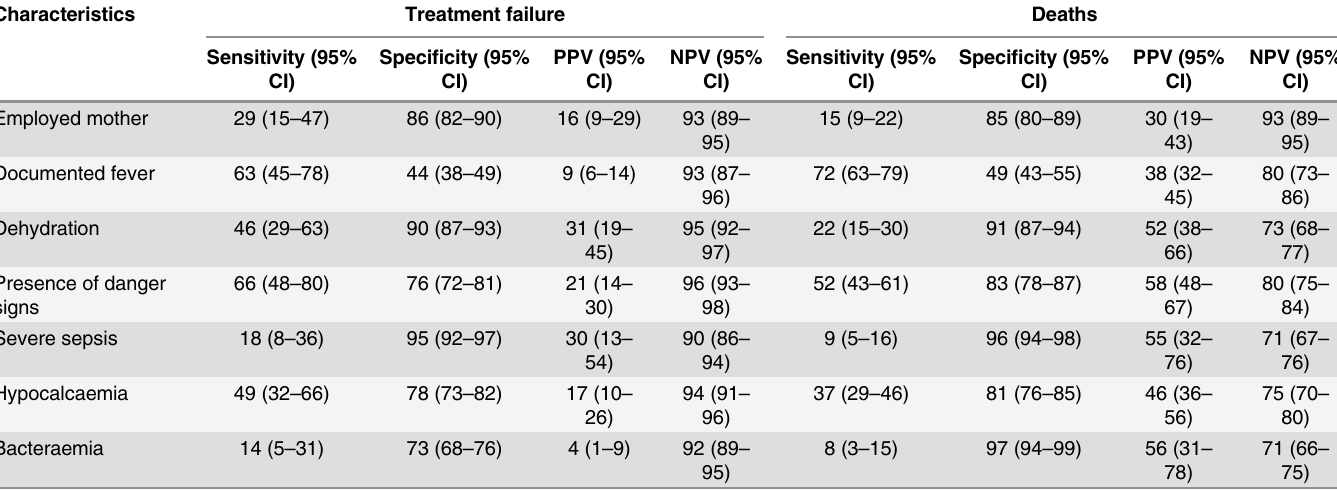
Table 7. Validity of predicting features of treatment failure and deaths in SAM children presenting with cough or respiratory difficulty and radiolog- ical pneumonia and who received standard WHO interventions.